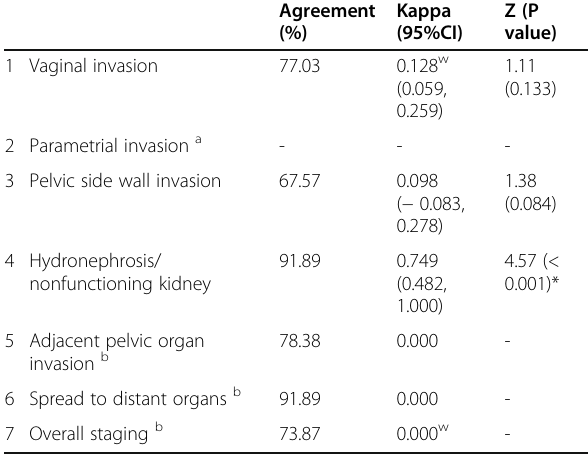
Table 2 Correlation of clinical staging and MRI staging in cervical cancer patients with pretreatment MRI (n =